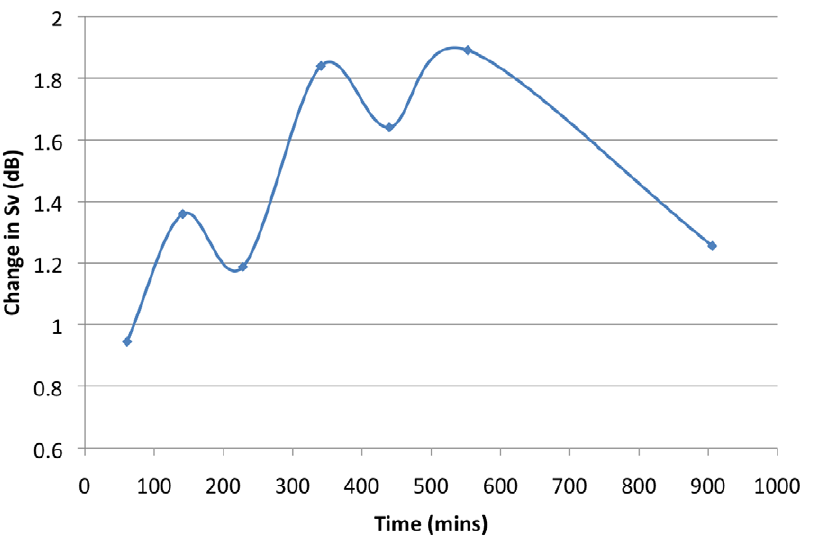
Figure 4. The difference in mean scattering volume at the center of each clover plotted against the time interval. The average change in backscatter was 1.9 dB over 550